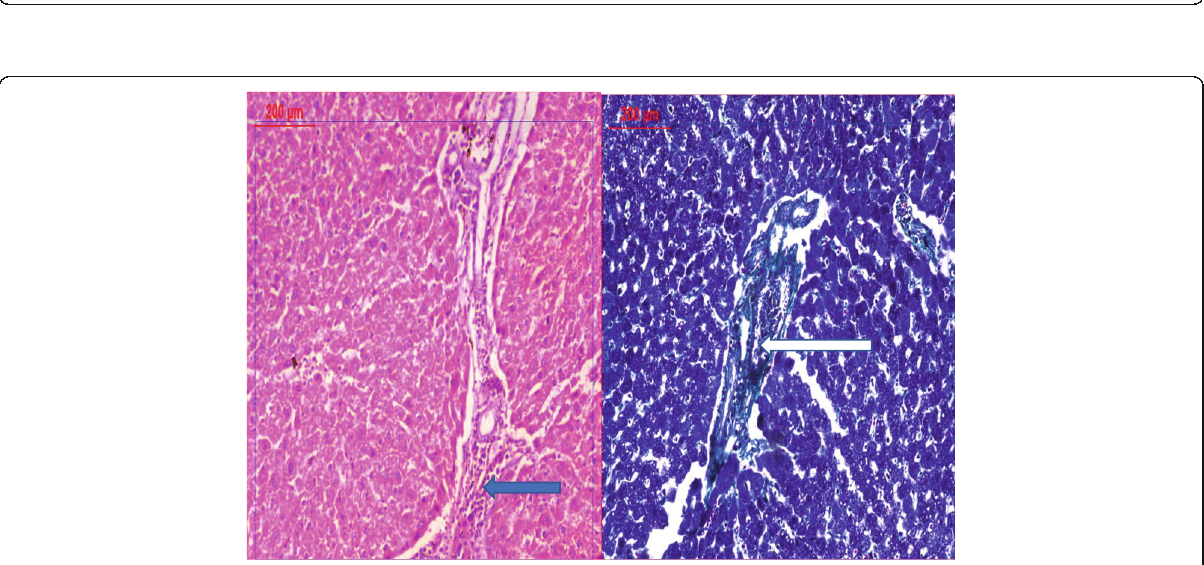
Fig. 5 Photomicrograph for the acetaminophen group: showing liver tissue with expanded portal tracts with bridging fibrosis and moderate inflammatory response (blue arrows), fibrosis demonstrated by Masson trichrome stain (white arrow) (× 200, × 400, × 100)